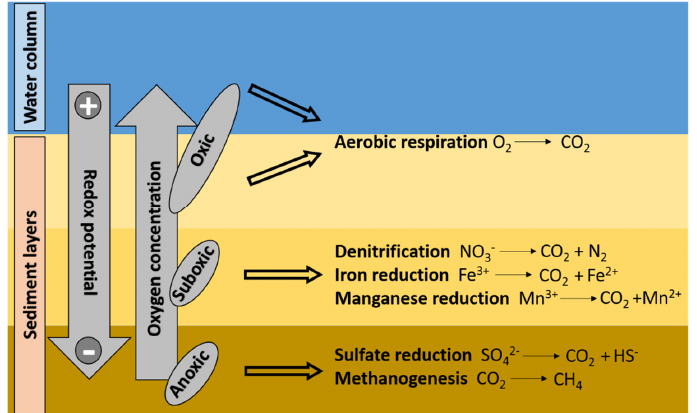
Figure 2. Conceptual scheme of metabolic processes involved in hydrocarbon degradation in marine sediments characterized by different redox conditions.